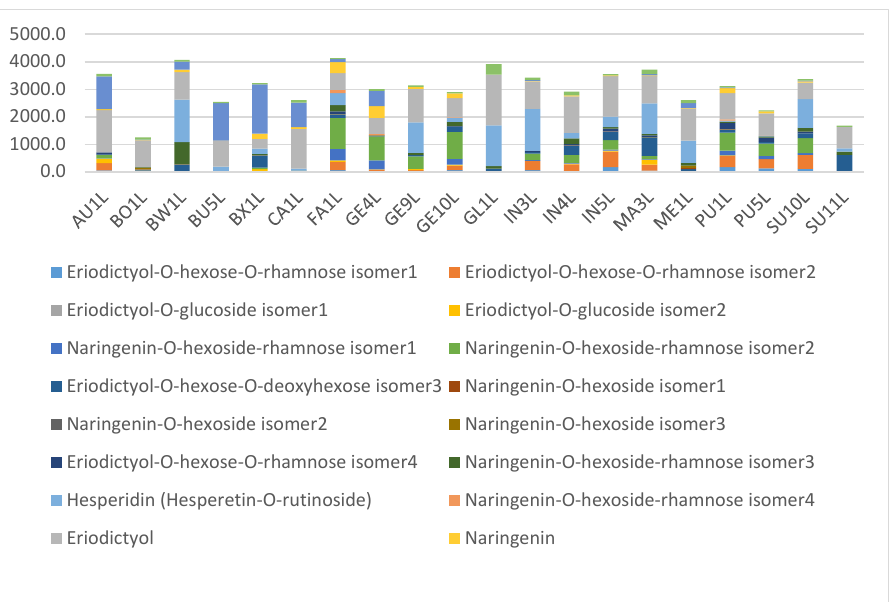
Figure 10. Average levels (mg/kg relative to mangiferin) of nine classes of phenolic compounds in leaf samples of 15 species of Cyclopia . The A at the end of the species codes means that it is an average value for all the leaf samples of that species analysed – see Table 2). C. aurescens (AU), C. bolusii (BO),